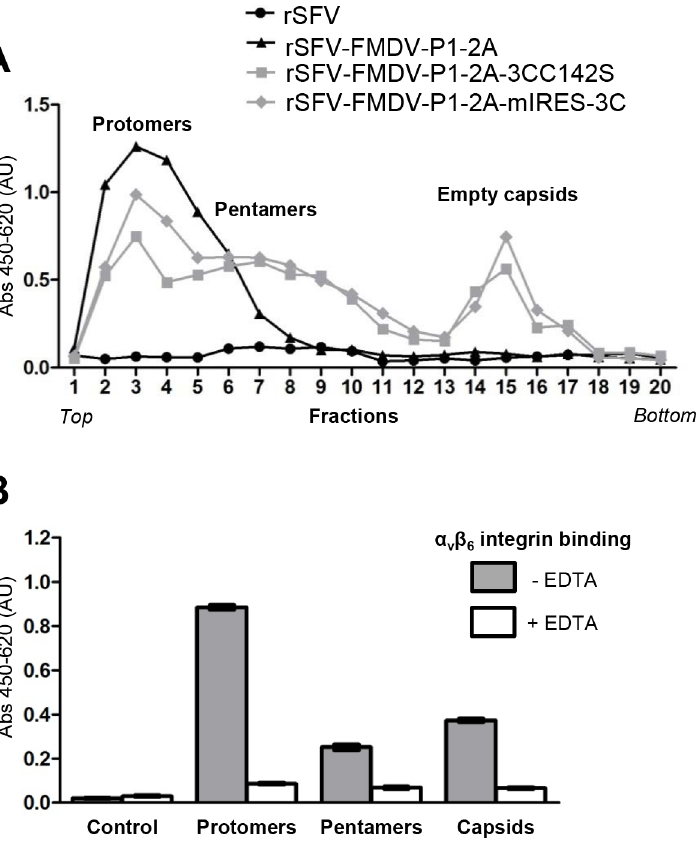
Fig 4. Assembly and properties of FMDV protomers, pentamers and empty capsids expressed from rSFV vectors. (A) BHK cells were infected as described in Fig 2 using the indicated rSFV-FMDVs. Cytoplasmic extracts were prepared (16 h post infection) and sedimented through sucrose gradients (10 – 30%) and fractionated. FMDV proteins from each fraction were detected using a serotype-specific antigen ELISA. The location of protomers, pentamers and empty capsids are indicated. (B) Fractions (fr) from the rSFV-FMDV-P1-2A-mIRES-3C infected BHK cells containing protomers (fr. 3), pentamers (fr. 7) and empty capsids (fr. 15) were assayed to detect FMDV antigen binding, in the presence or absence of EDTA as indicated, to the integrin α v β 6 coated directly onto plates. Binding buffer was used as the control. Results are presented as mean ± SEM of triplicate